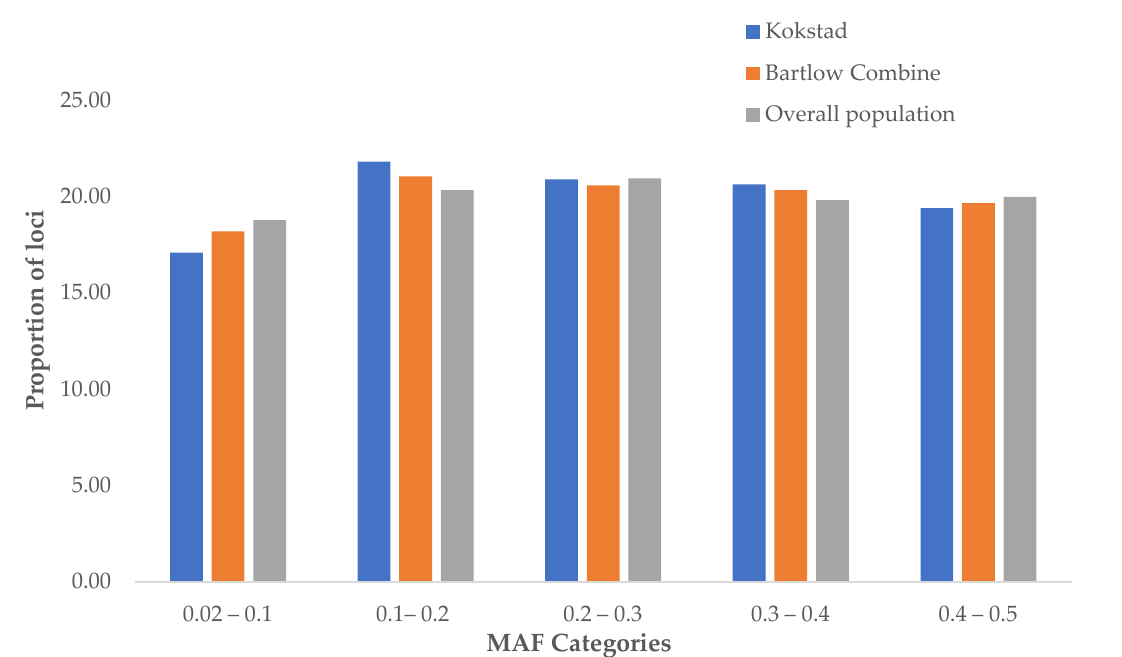
Figure 1. Distribution of minor allele frequencies in Bartlow Combine, Kokstad, and overall Nguni cattle populations. Proportion of the SNPs (Y-axis) from the HD chipset after quality control found inside each MAF category (X-axis) was averaged for both populations.